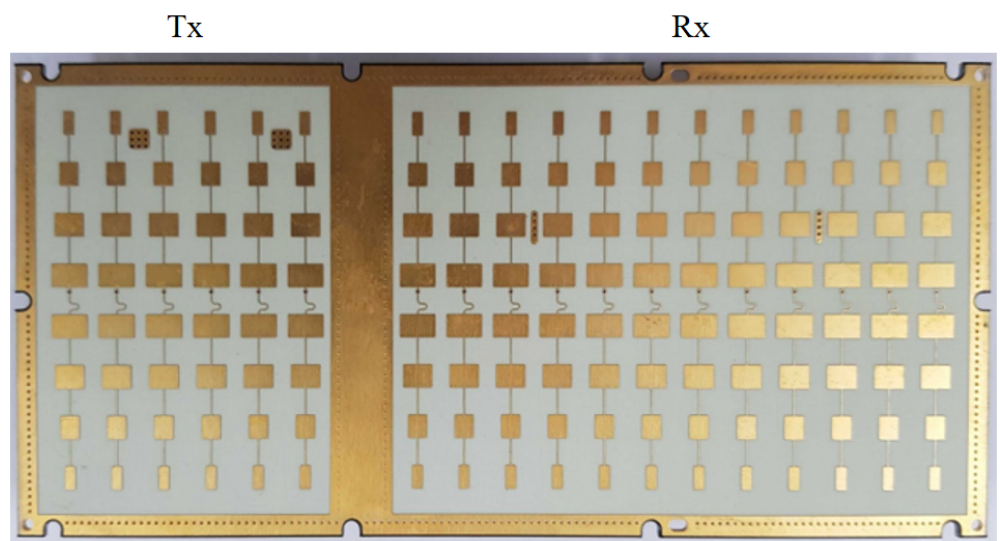
Figure 3. Antenna system of our traffic monitoring radar: one transmit antenna element and four receiving antenna elements.